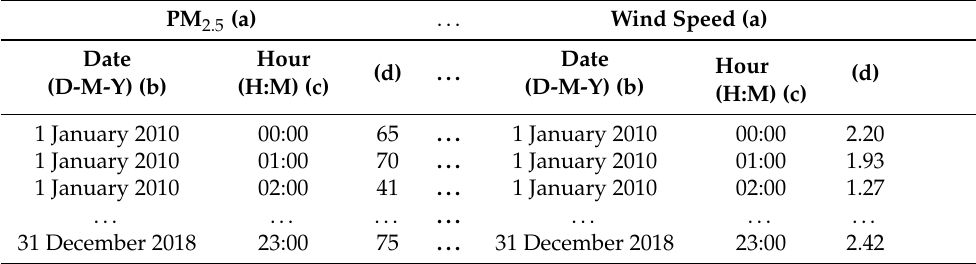
Table 1. Basic structure of meteorological and pollutant data.